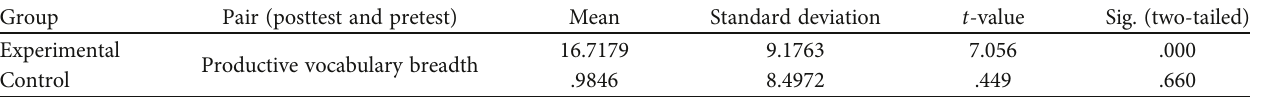
(experimental group mean = M1 = 16.7179, control group mean = M2 = .9846, standard deviation of experimental group = sd1 = 9.1763, and standard deviation of control group = sd2 =